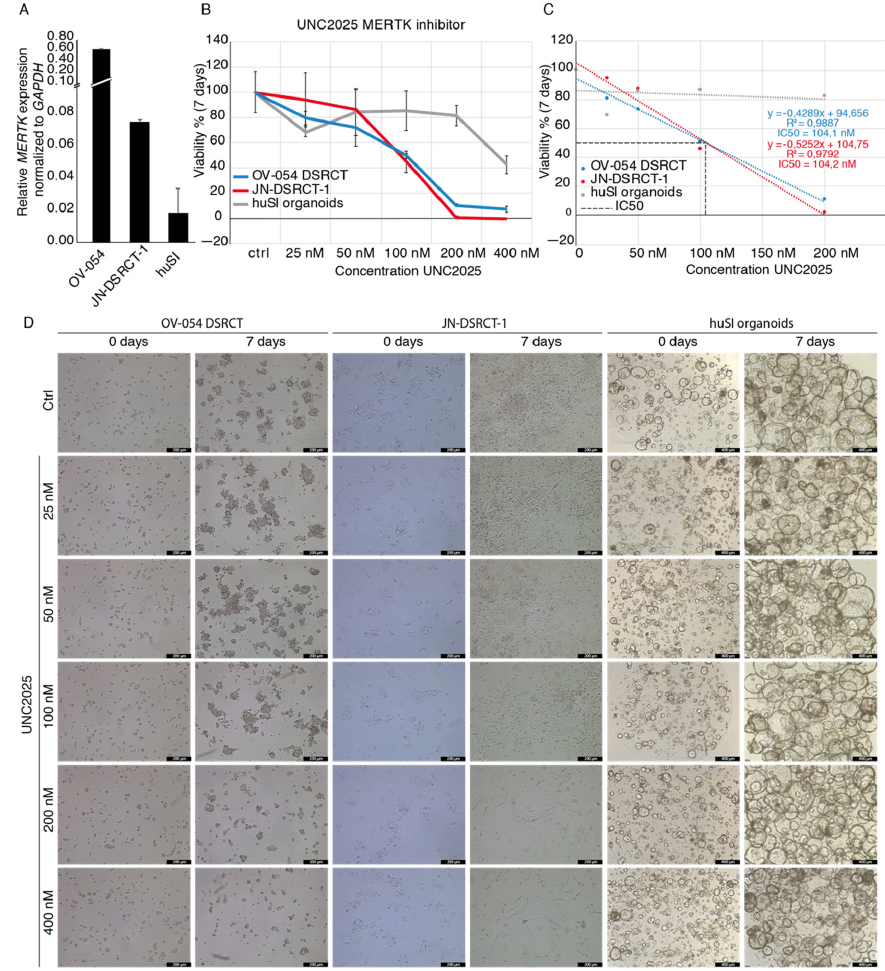
Figure 7. MERTK inhibitor UNC2025 affects DSRCT tumor expansion in vitro. ( A ) Barplot depicting qPCR results of relative MERTK expression in OV-054, JN-DSRCT-1, and huSI organoids, normalized to GAPDH . ( B ) Graph depicting cell viability of OV-054 DSRCT, JN-DSRCT-1, and huSI organoids, upon administration of 0, 25, 50, 100, 200, and 400 nM UNC2025. ( C ) Graph depicting IC50 of UNC2025 on both OV-054 DSRCT and JN-DSRCT-1 cells ( D ) Representative pictures of OV-054 DSRCT, JN-DSRCT-1, and huSI organoids in vitro, days 0 and 7, after administration of 0, 25, 50, 100, 200, and 400 nM UNC2025 (10× objective).